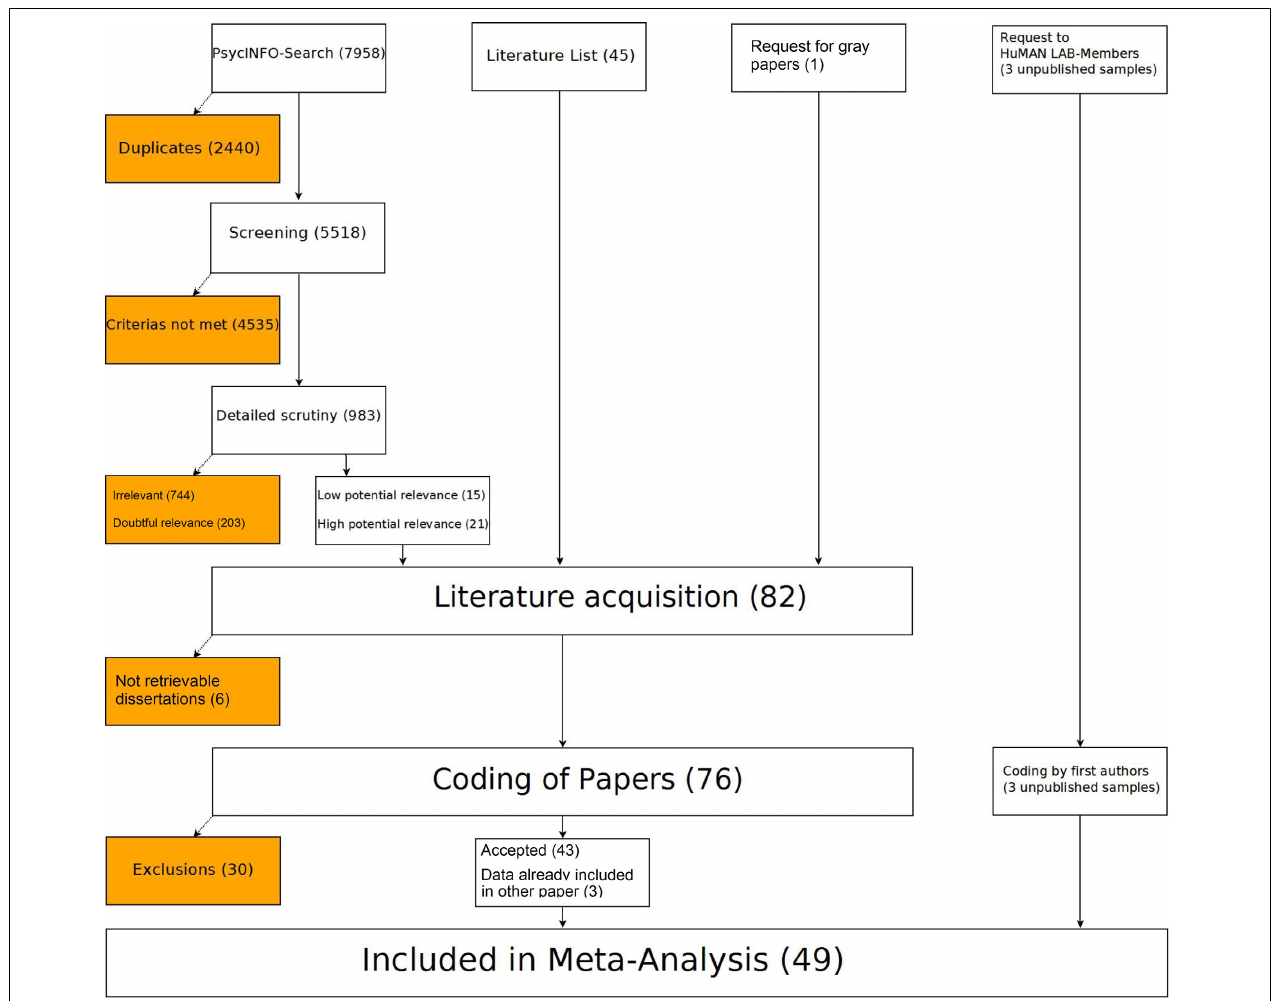
FIGURE 1 | Overview of the procedure used in collecting and analyzing the literature with number of studies in the respective subsample given in brackets. White background, retained; dark background,